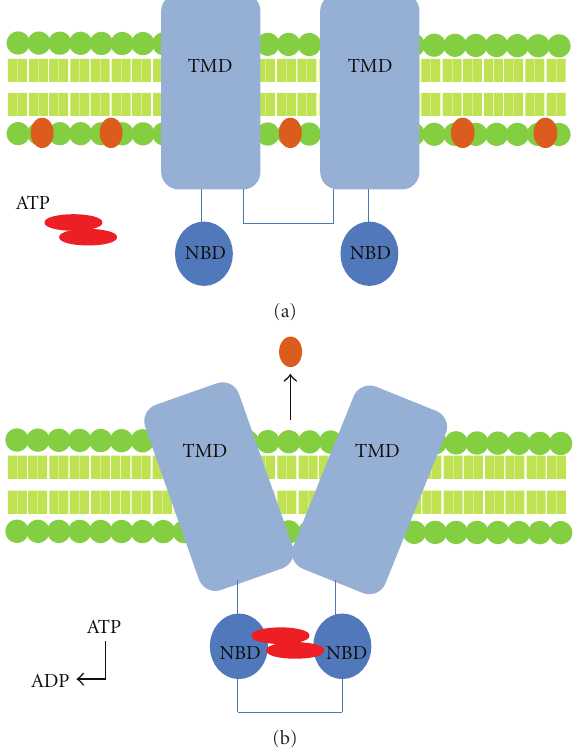
Figure 1: (a). An example of the general structure an ABC trans- porter with 2 sets of transmembrane domains (TMD) and 2 nucleotide binding domains (NBD). Substrate molecules are present in the inner membrane shown in orange. Upon binding of ATP, the NBD become joined, leading to a conformational change (b). This change causes the movement of the substrate out of the membrane.